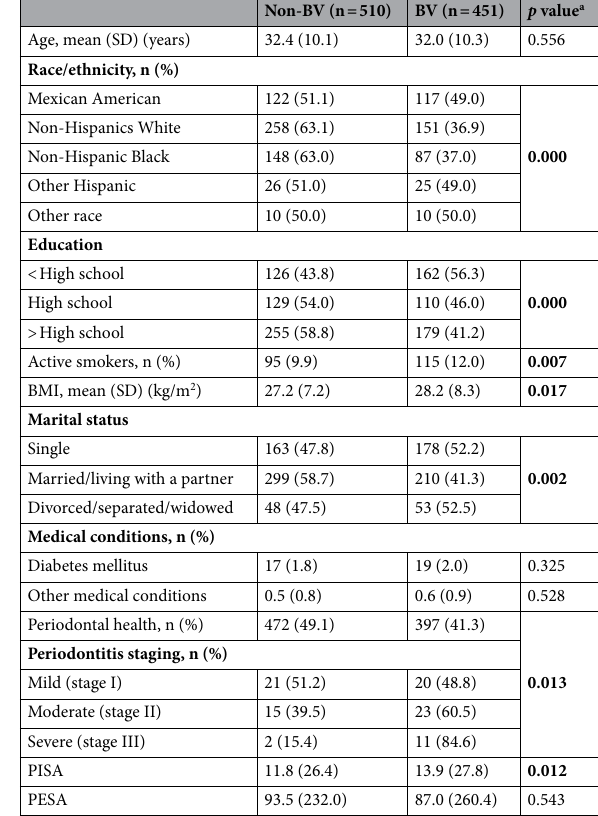
Table 1. Participants characteristics. Significant correlations are identified in bold ( p < 0.05). BV, patients with bacterial vaginosis; n, number; SD, standard deviations; Non-BV, patients without bacterial vaginosis; PESA, periodontal epithelial surface area; PISA, periodontal inflamed surface area; <, higher than; >, less than. Values are given as mean (standard error) or % (standard error). a Chi-square test for categorical variables, Mann– Whitney test for continuous variables, p <